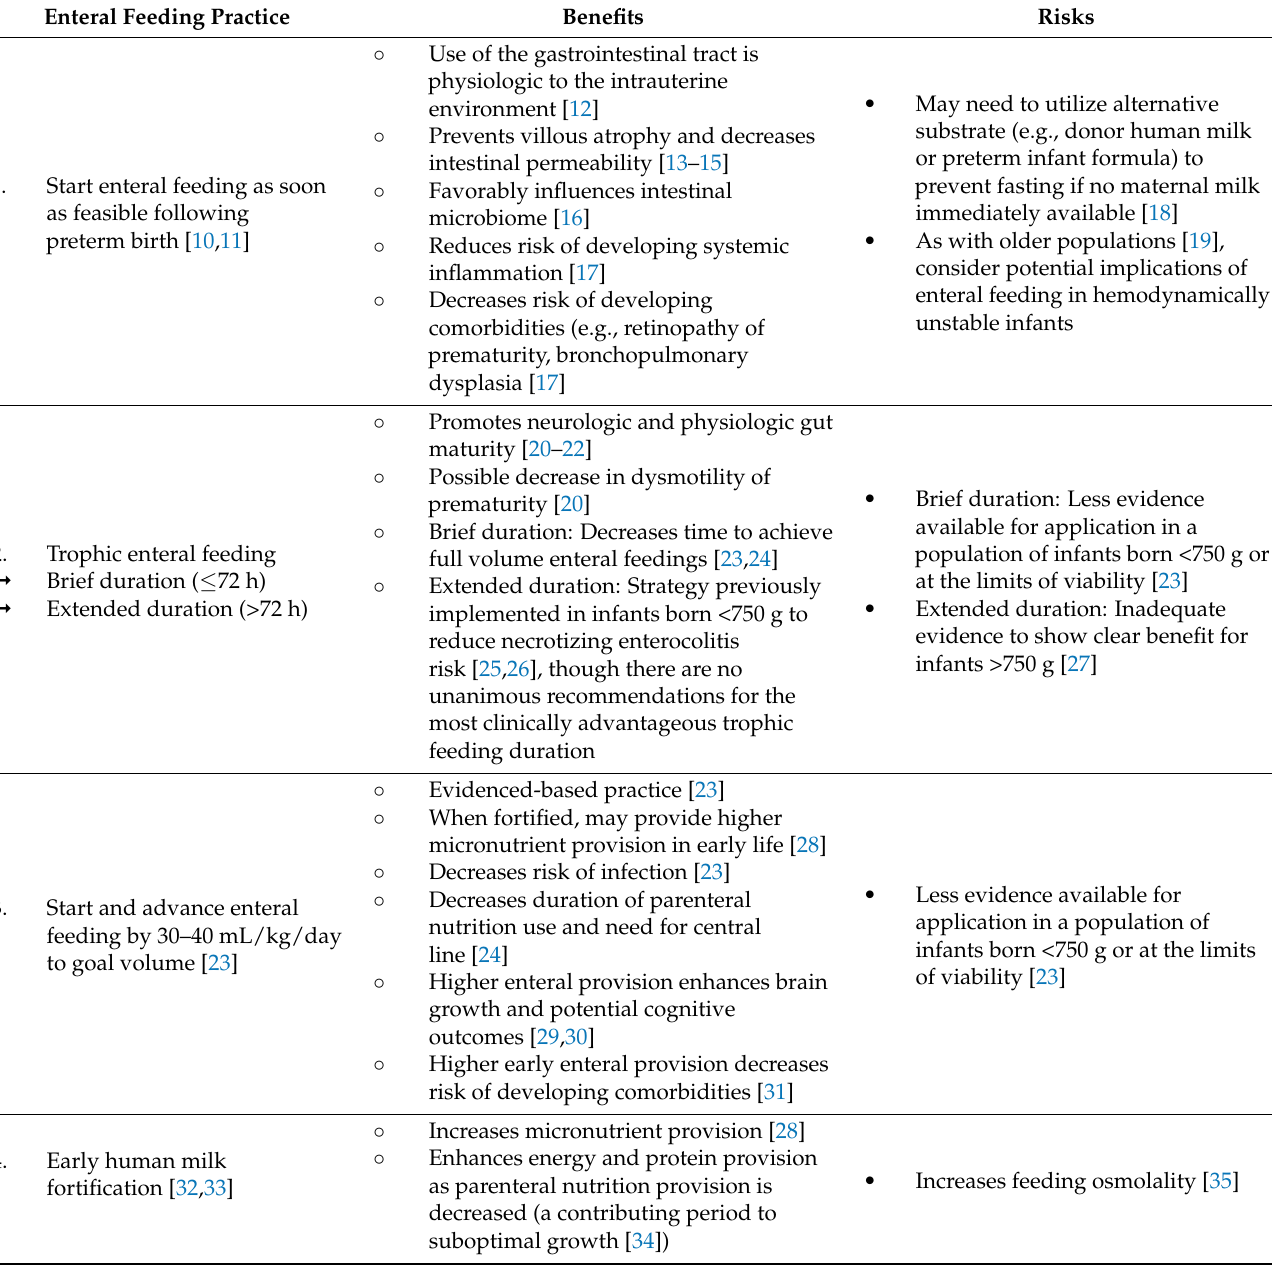
Table 1. Benefits and risks of early life enteral feeding practices in preterm